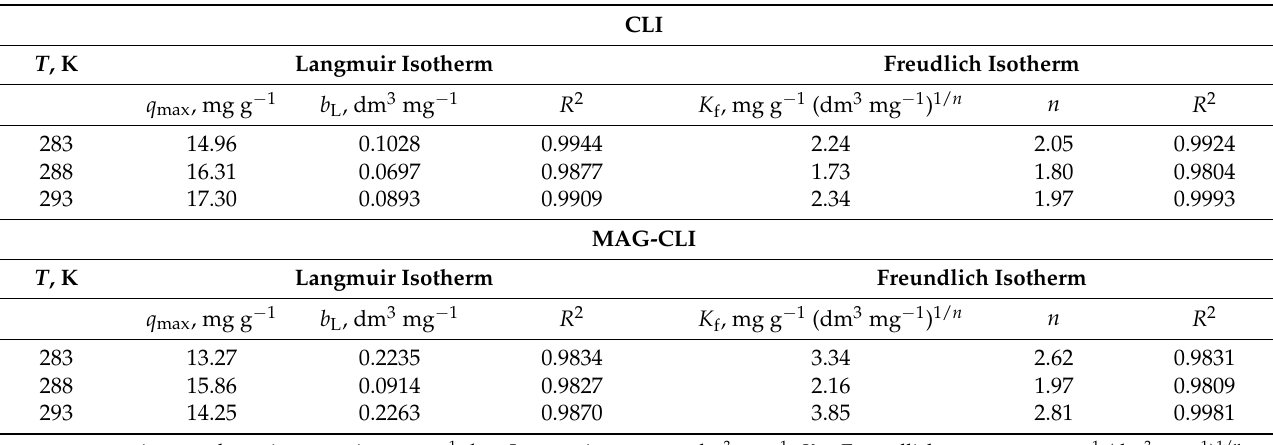
Table 4. The parameters obtained by the adsorption isotherm Equations (2) and (3) for the adsorption of CIP on CLI and MAG-CLI; R 2 is the correlation coefficient.